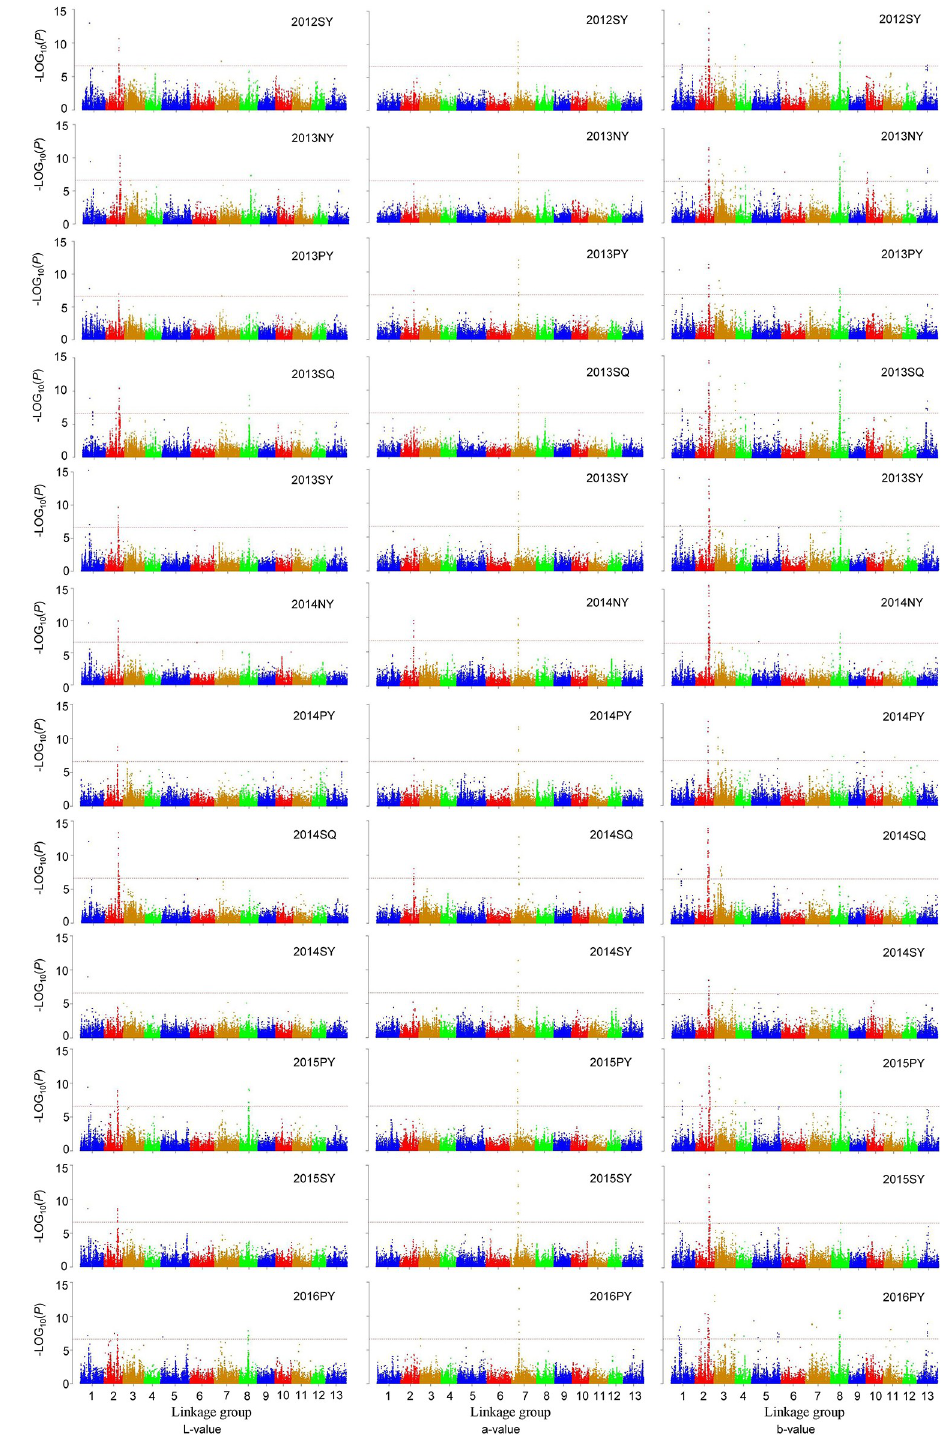
Fig 3. Genome-wide association studies (GWAS) of seed coat color in twelve environments. The red horizontal dashed lines indicate the genome-wide significance threshold ( P < 2.34 × 10 − 7 ).